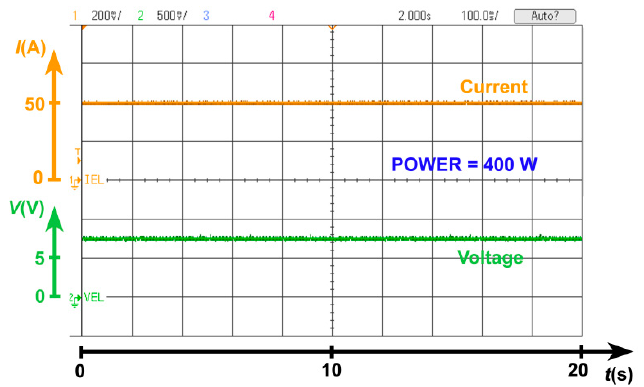
Figure 14. Voltage and current at the terminals of the electrolyzer with rated power.